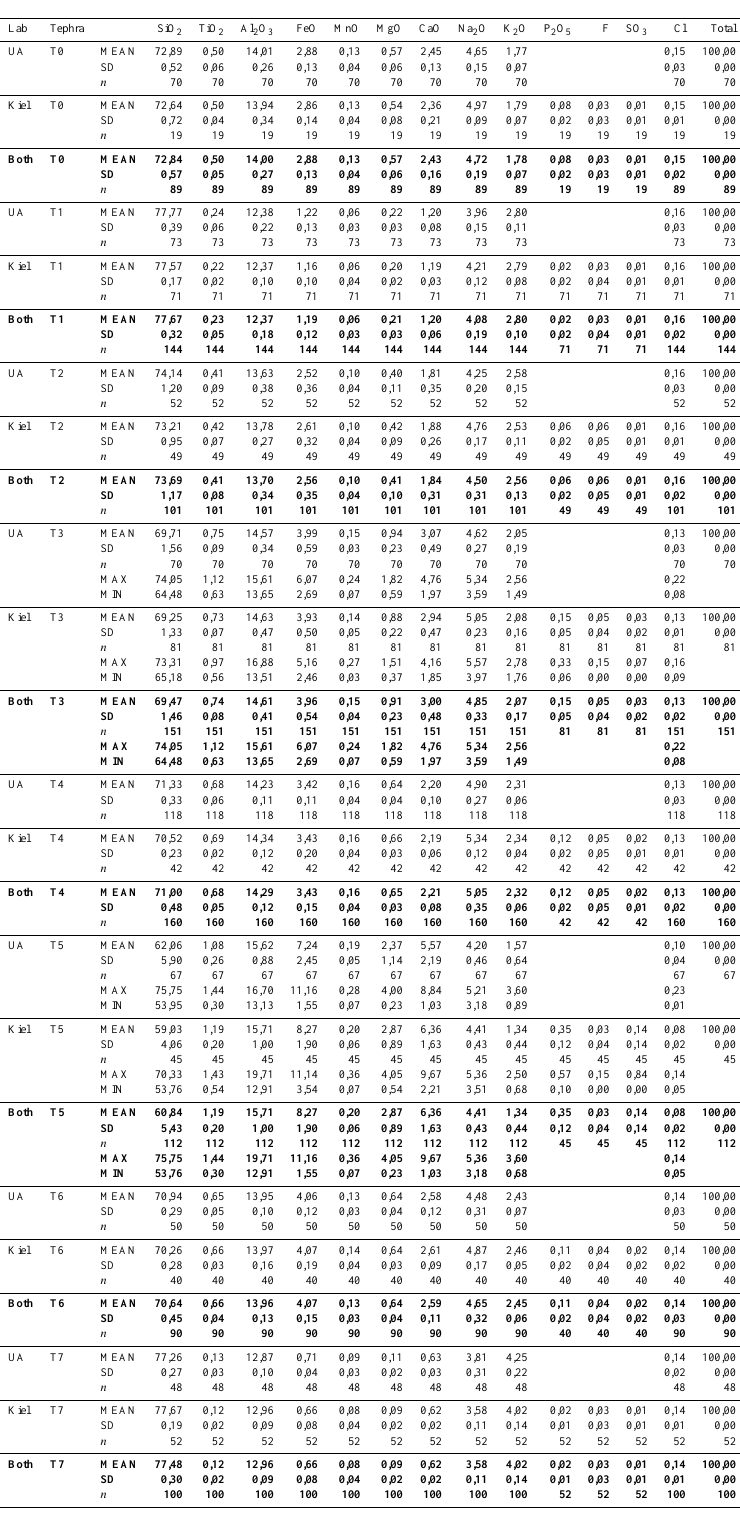
Table 2. Major-element geochemistry of Lake El’gygytgyn tephra from both the University of Alberta (UA) and Kiel laboratories given as averages. Both = data from UA and Kiel combined. Analyses of single glass shards are provided in the Supplement Tables S1 and S3. MAX and MIN values for tephra T3 and T5 show the range in